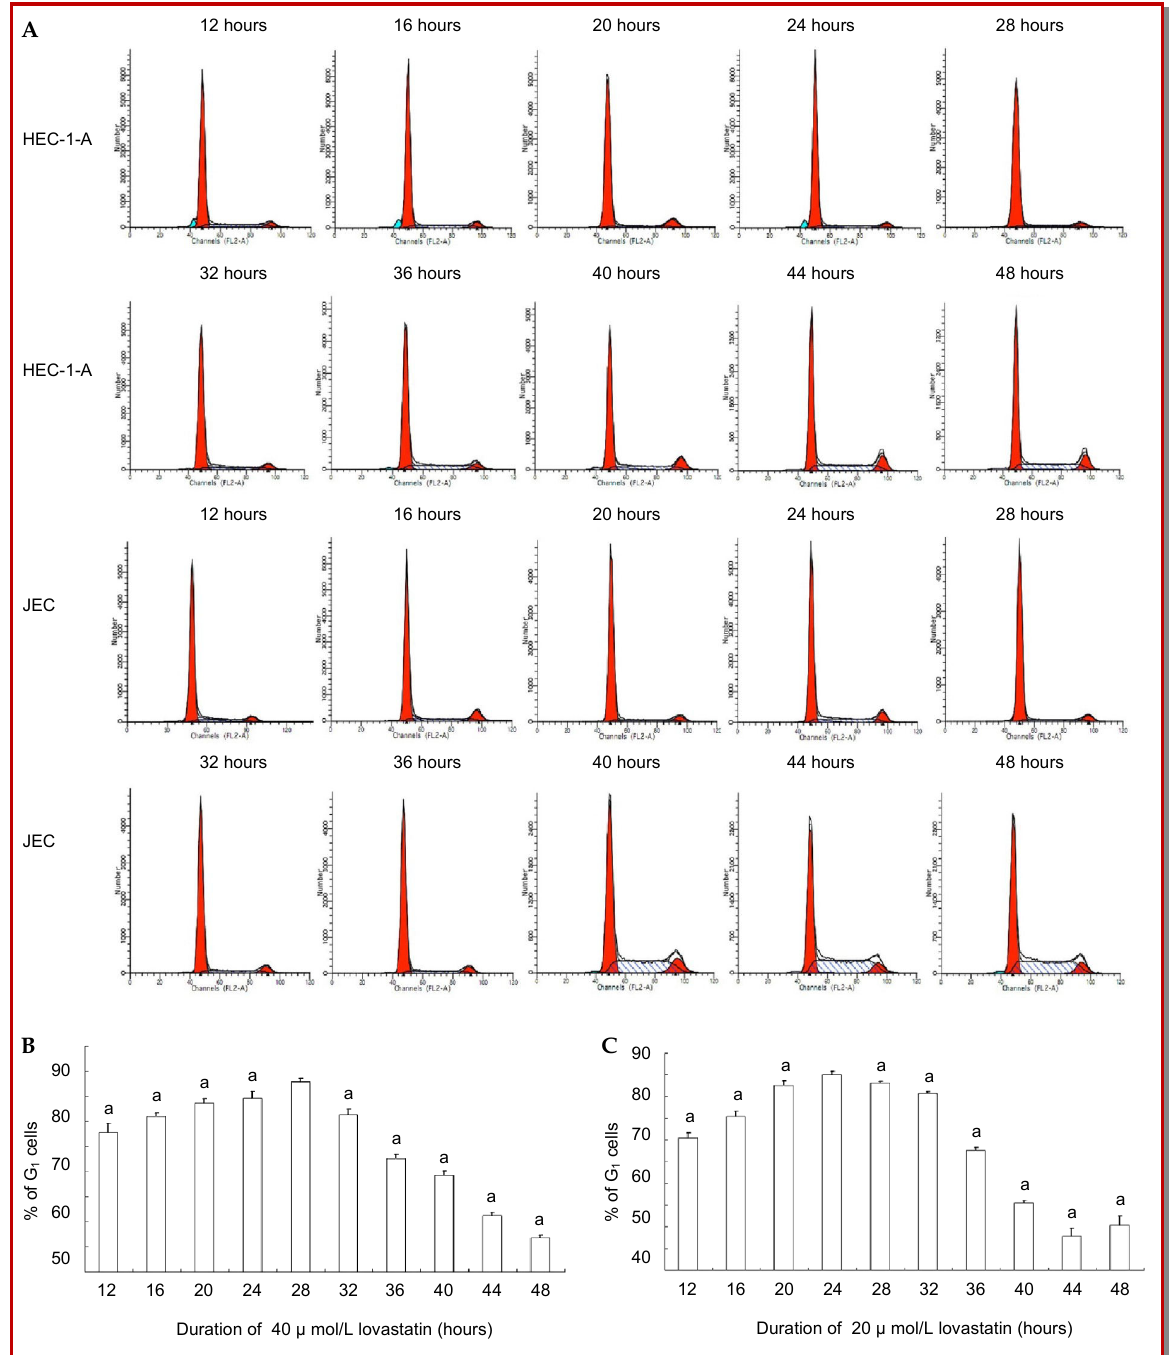
Figure 2: Optimal duration of Lovastatin treatment for G1-synchronization. (A) Flow cytometry of HEC-1-A cells following treat-